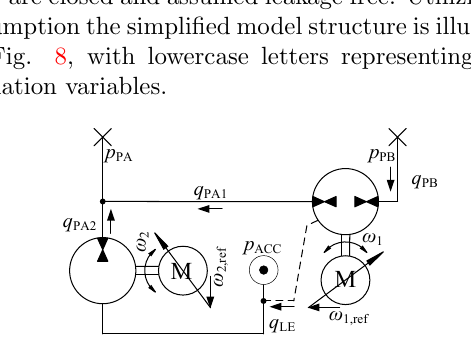
Figure 8: Simplified model system structure in load holding mode, used for deriving linearised